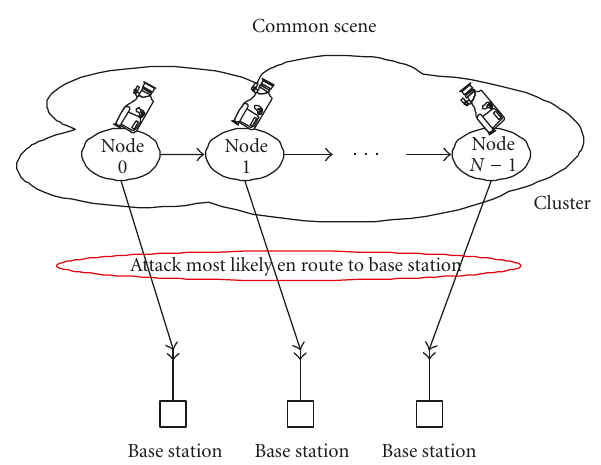
Figure 1: Communication scheme, layout of a cluster, and the most common point of attack.